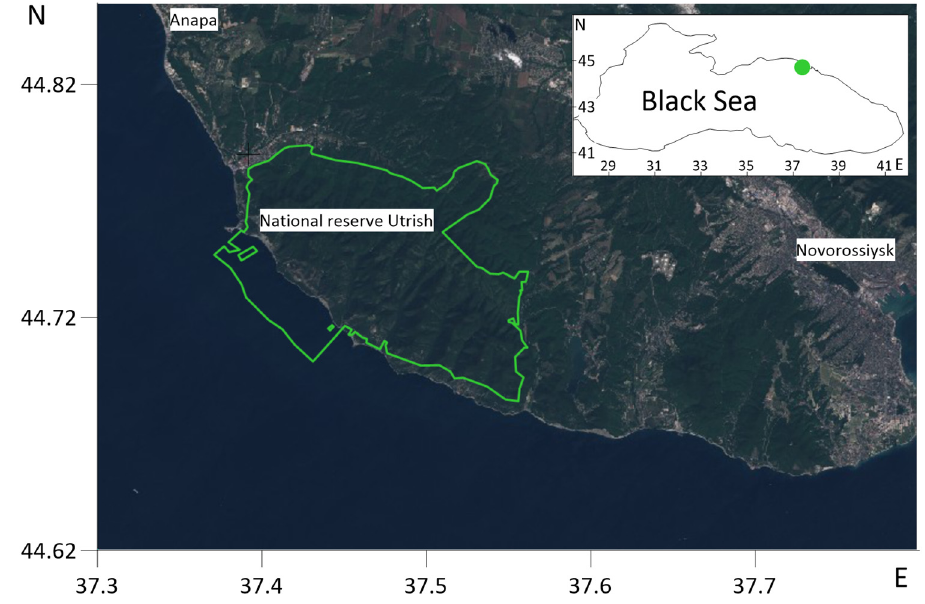
Figure 1. Location of the NR Utrish in the Black Sea.